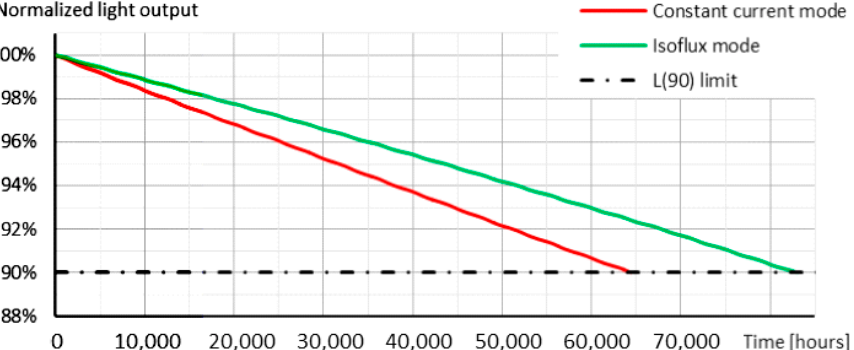
Figure 11. Simulated lifetime budget of a Luxeon Z LED. Table 3. Comparison of operation with constant forward current (700 mA) and with constant light output (425 mW), simulated with the help of our LED aging theory.